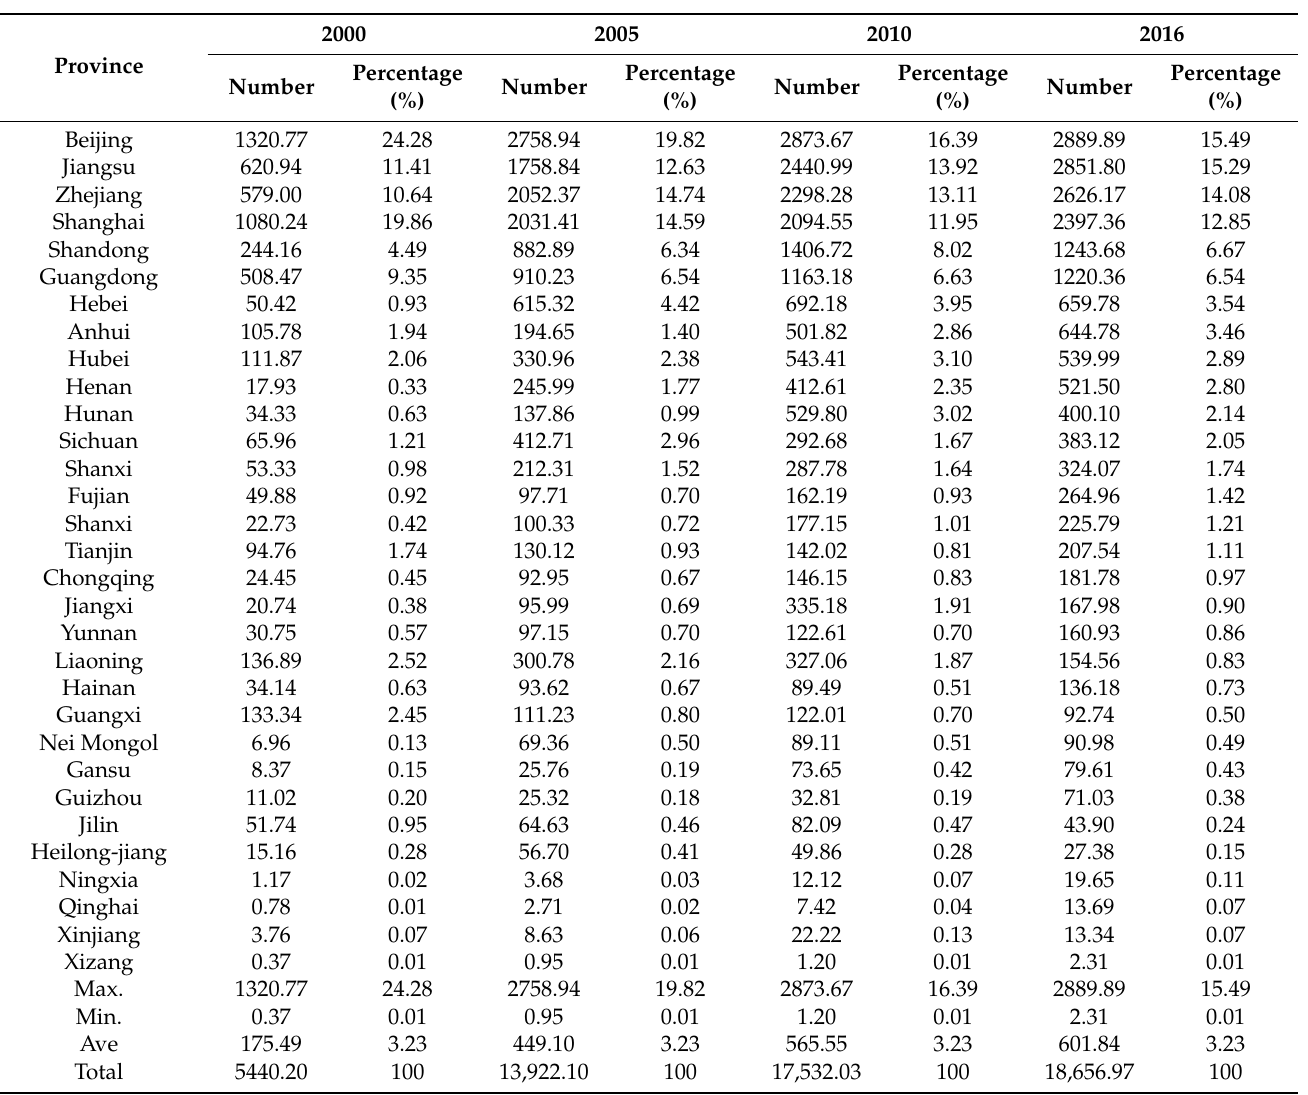
Table 1. Spatial correlation quantity of tourism investment in each province of China from 2000 to